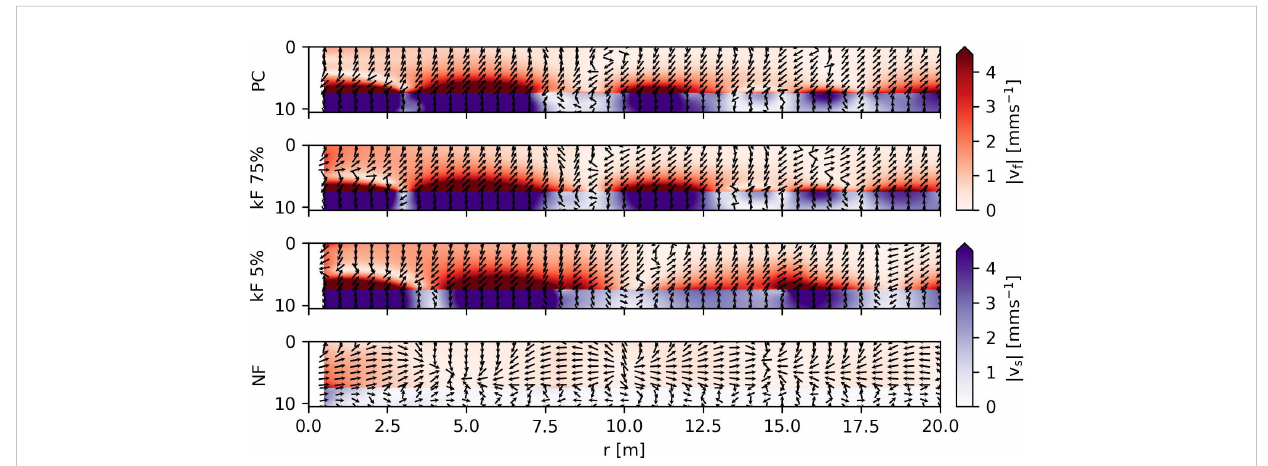
FIGURE 11 Snapshot of particle velocity norm in mm s – 1 in fl uid and soil domains including velocity directionality.